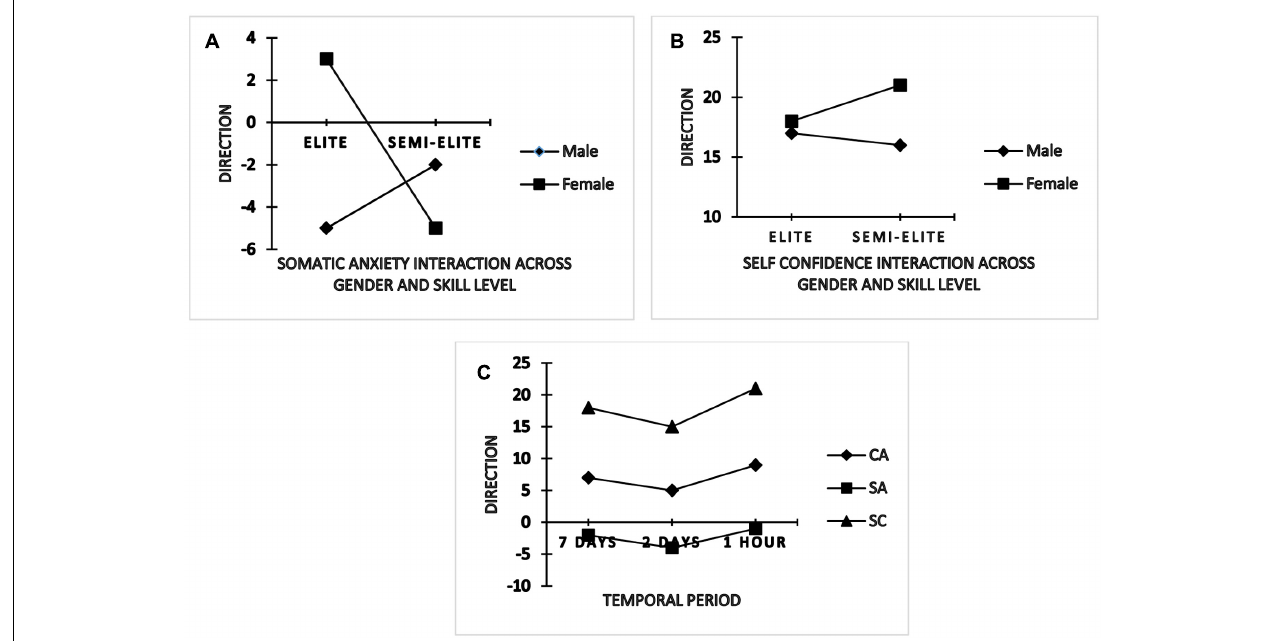
FIGURE 2 | Interactions and time-to-event anxiety and self-confidence directional changes.